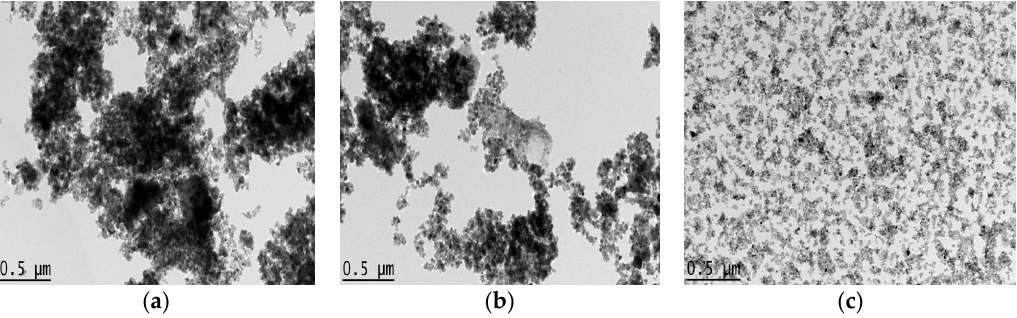
Figure 4. TEM images of: ( a ) MNP; ( b ) MNP@PTh; ( c ) MNP@PTArH.